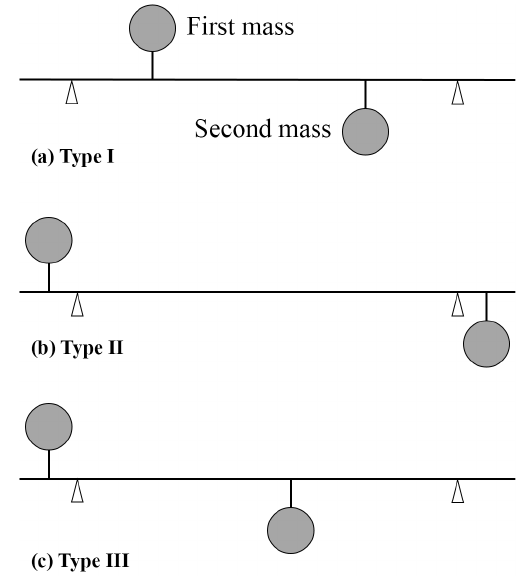
Figure 4. Equivalent balance shaft model with bearing reaction in inline 3-cylinder engine (first bearing: black triangle, second bear- ing: white